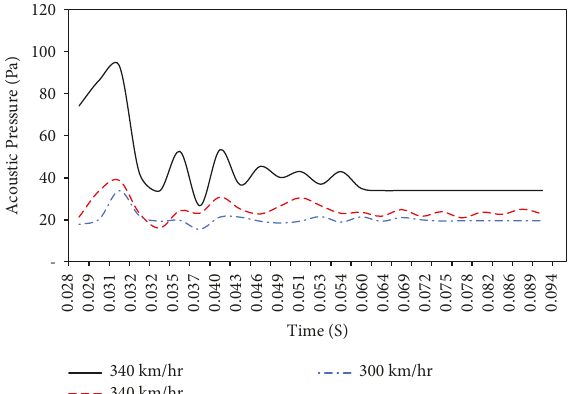
Figure 13: Comparison of acoustic pressure measured at the pantograph panhead for the three different train